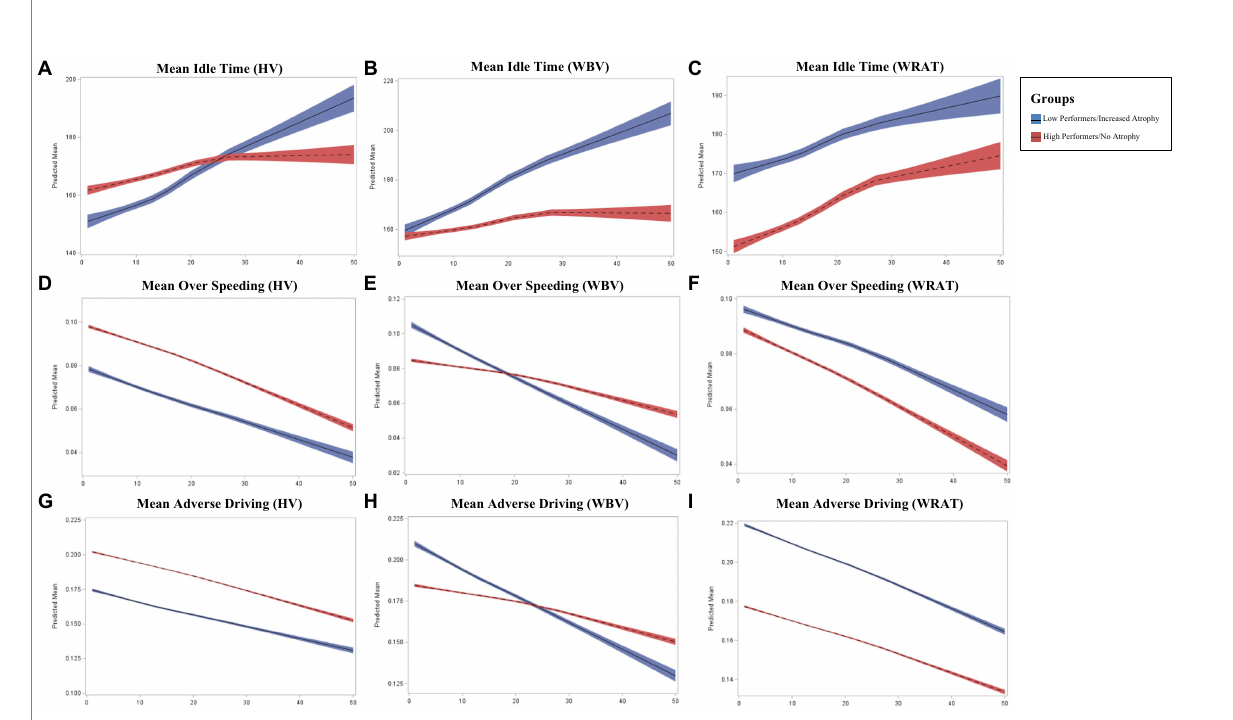
FIGURE 1 Longitudinal change in adverse driving outcomes across groups where x -axis represents the number of months (0–50) and y -axis represents the predicted mean in driving outcome (A–I) .